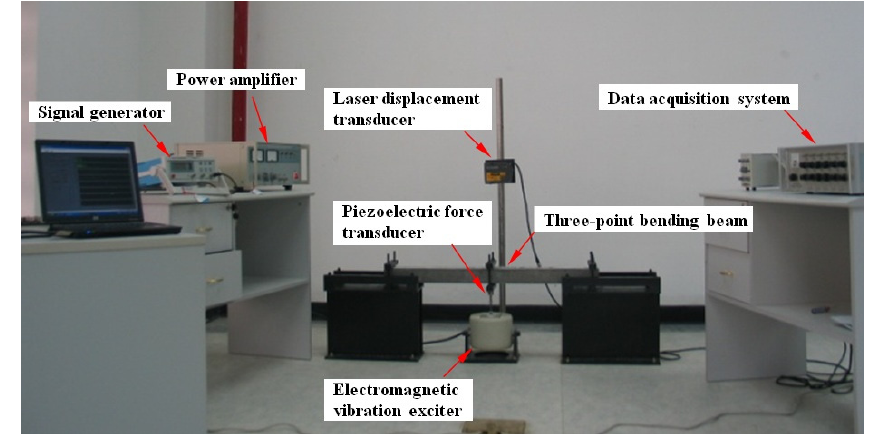
Figure 2. Three-point dynamic bending testing device.